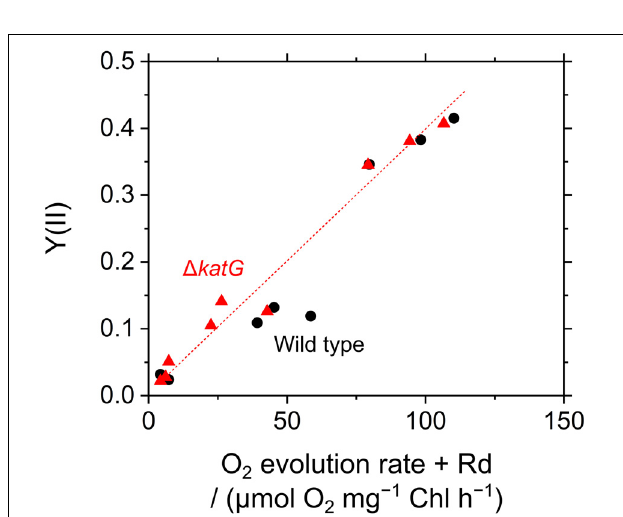
FIGURE 7 | Relationship between the incident quantum yield of PSII, Y(II), and photosynthetic O 2 evolution rate accelerated by exogenous H 2 O 2 in Synechococcus elongatus PCC 7942. Photosynthetic O 2 evolution rate is shown as the sum of net O 2 evolution rate and dark respiration rate (Rd). Data of both Y(II) and O 2 evolution rate were obtained in (1) phase α , (2) phase β , and (3) phase β with exogenous H 2 O 2 (50 µ M), respectively, in the wild type (black circles) and in the (cid:49) katG mutant (red triangles). Experiments were performed three times (technical replicates).